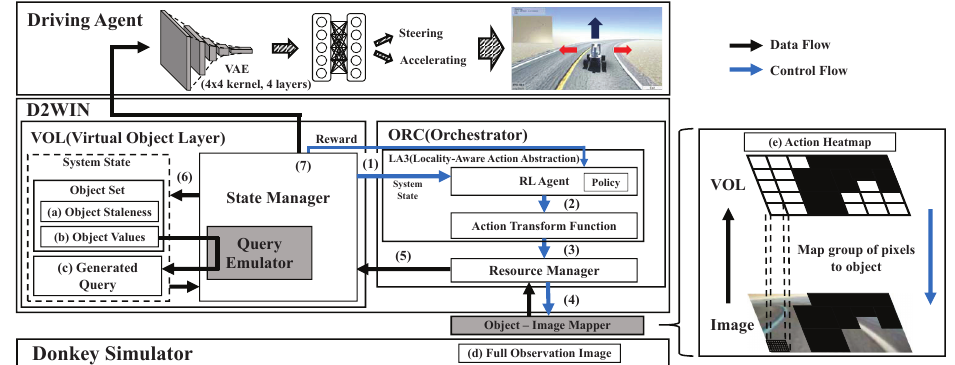
Figure 17. Case study system architecture: for this simulation test, we implemented two additional modules, i.e., query emulator and object-image mapper, in addition to the generic framework explained previously. The two modules are denoted by the gray box. Importantly, the implementation and integration of the two modules requires no modification in the simulator (which emulates a system environment with many sensors) or the driving agent (which emulates a domain specific application in Figure